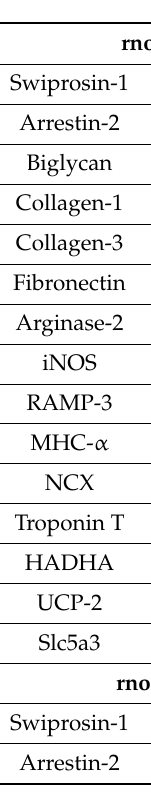
Figure 4. Correlation between swiprosin-1 mRNA ( A ), infarct size (as quantified by troponin I plasma concentration) ( B ), and arrestin-2 ( C ), with the abundancy of rno-miR-32-3p and rno-miR-34c-3p. Table 2. Correlation between miRs and